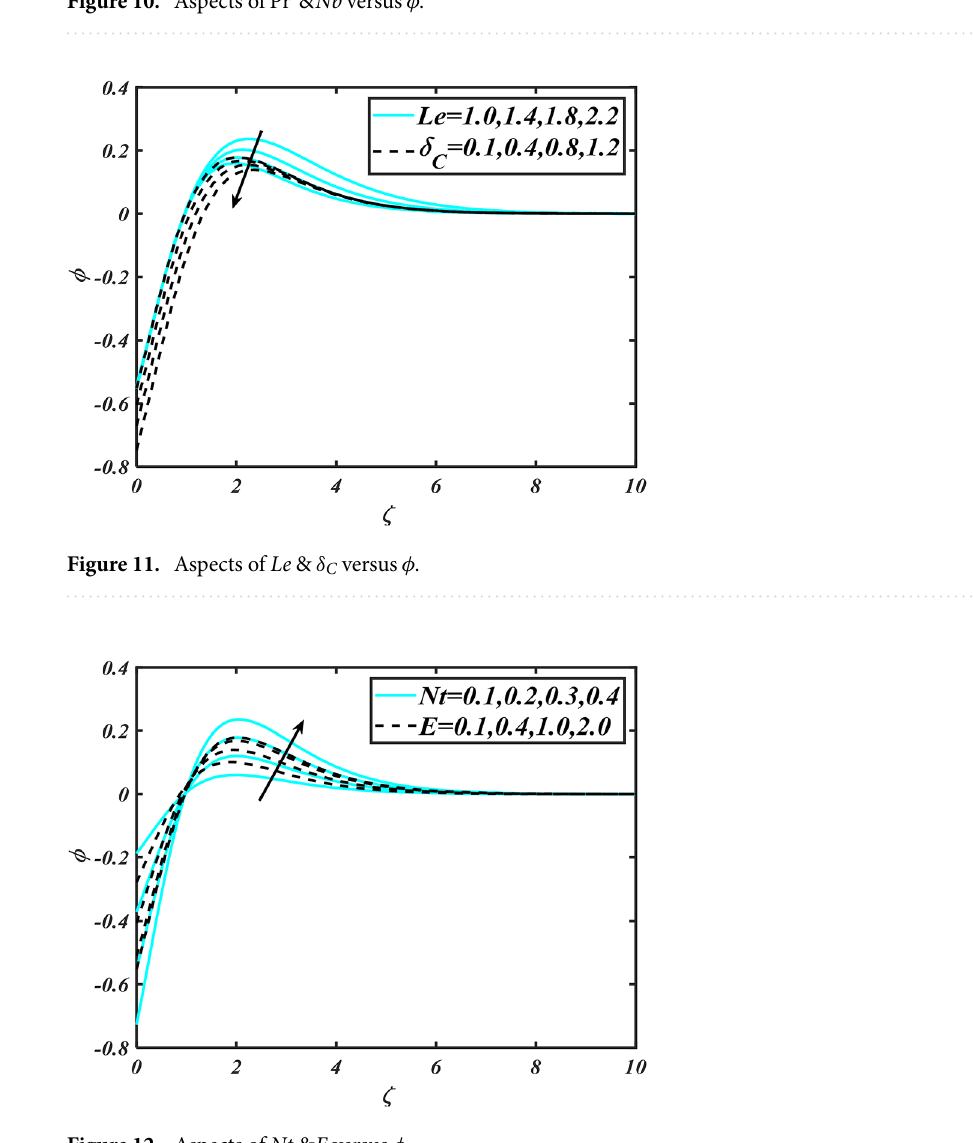
Figure 10. Aspects of Pr & Nb versus φ .